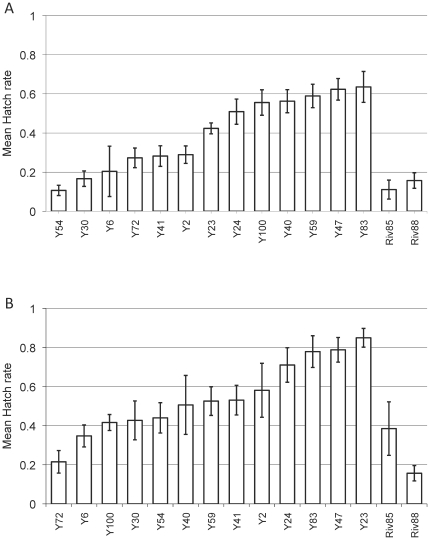
Hatch rates of 13 Y09 lines tested in the lab, demonstrating variation among these lines and their differences from Riv85 and Riv88.Males are aged A) 7 days; and B) 14 days post-eclosion.